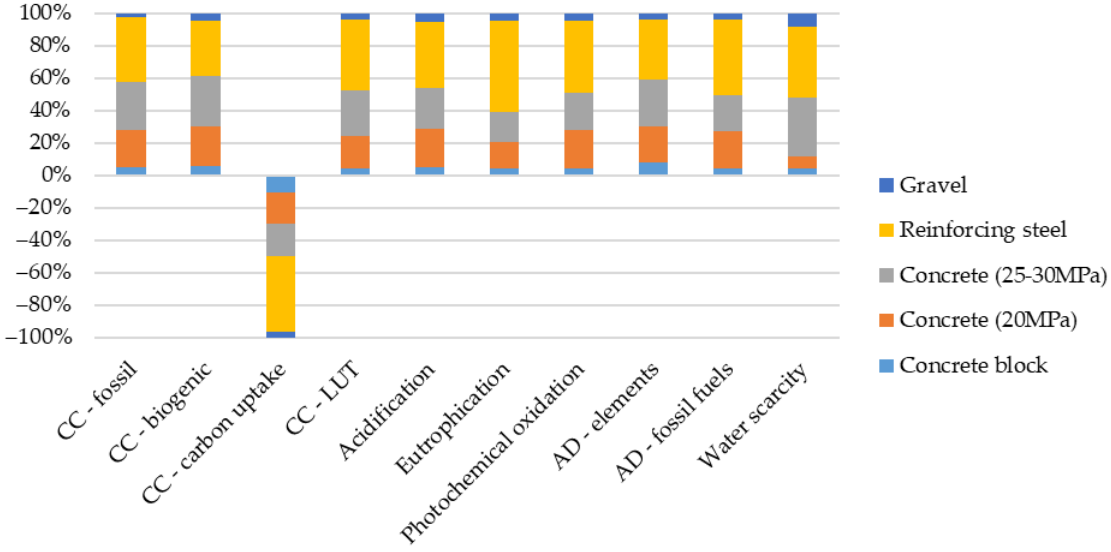
Figure 12. Impact assessment of peripheral wall construction materials.